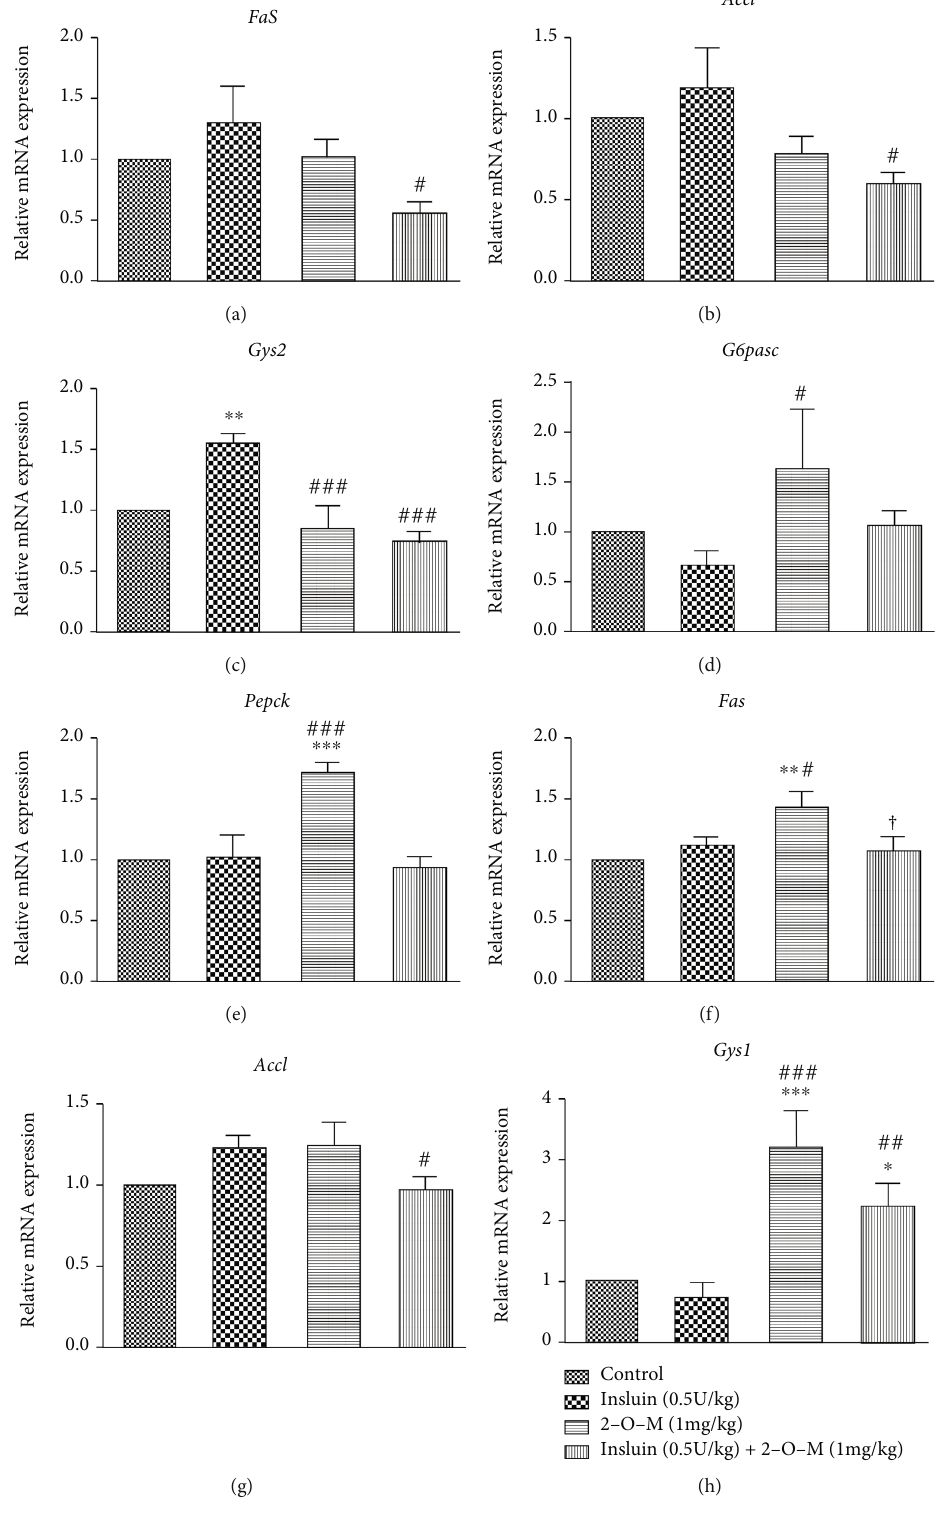
Figure 5: E ff ect of 2 ′ -O-methylperlatolic acid (2-O-M) on the insulin signal pathway in muscle and liver tissues of diabetic mice. (a) Expression of key proteins of insulin signaling pathway in liver. (b) Expression of key proteins of insulin signaling pathway in muscle. Data are shown as the mean ± SEM ( n = 4 – 8 in each group). ∗ p < 0 : 05 ; ∗∗ p < 0 : 01 ; ∗∗∗ p < 0 : 001 versus control. # p < 0 : 05 ; ## p < 0 : 01 ; ### p < 0 : 001 versus insulin. † p < 0 : 05 ; †† p < 0 : 01 , 2-O-M versus